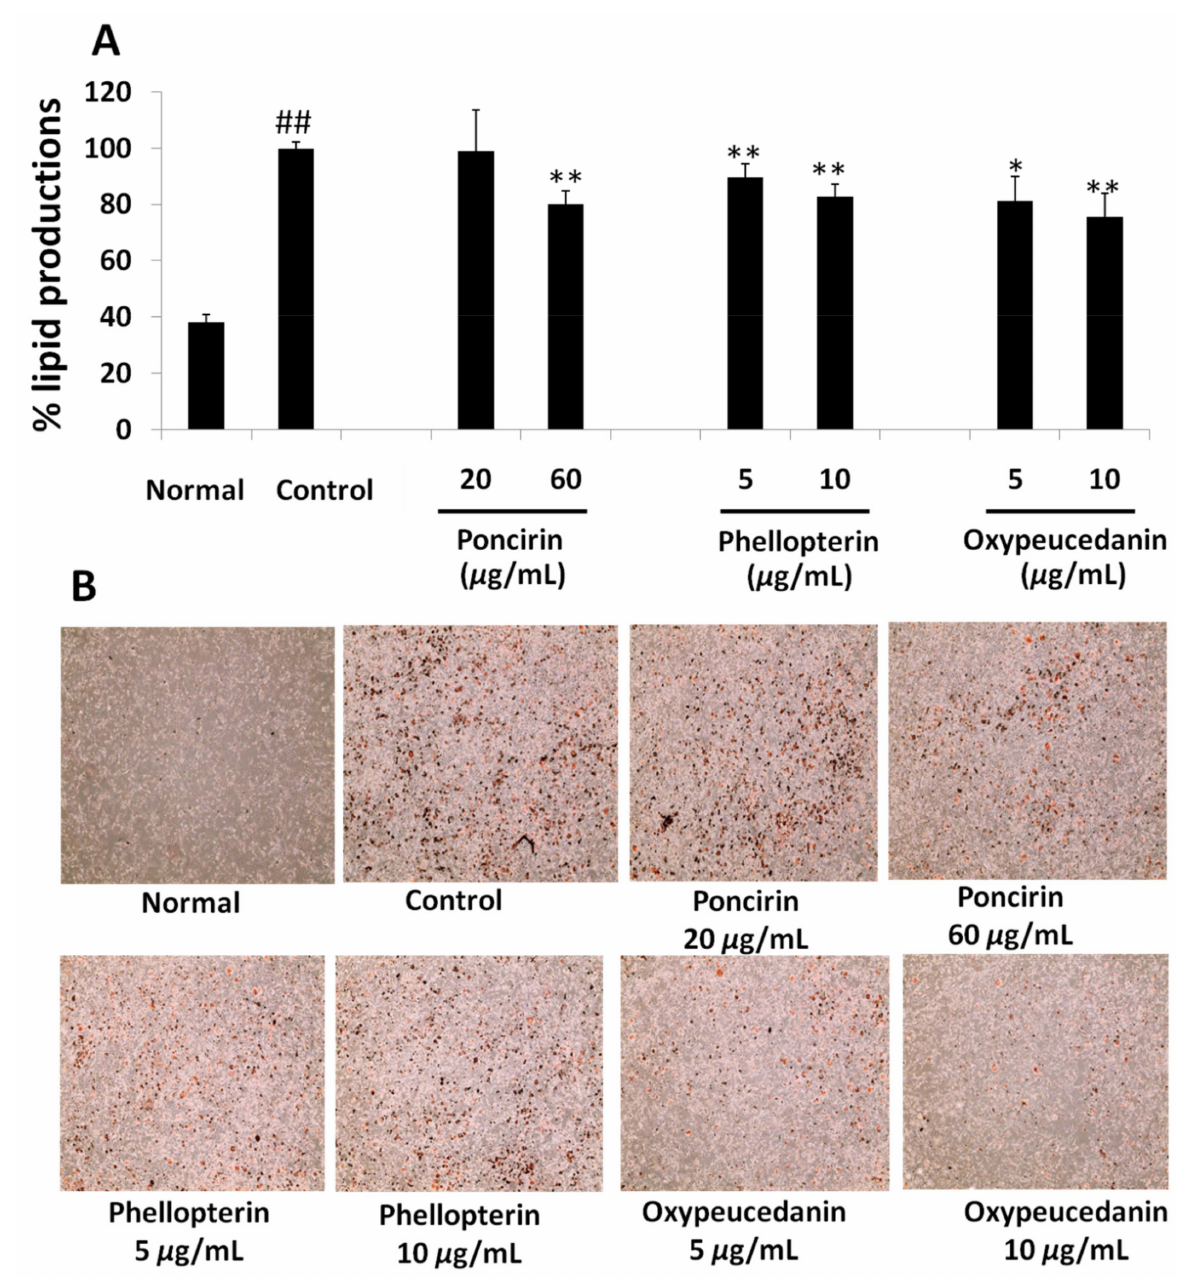
Figure 6. ( A )Effect of poncirin, phellopterin and oxypeucedanin treatment on percentage lipid deposition by 3T3-L1 cells using ORO assay. ( B ) Lipid accumulation in 3T3-L1 cell observed by EVOS XL microscope at 10 × magnification after ORO staining. Each set of data represents mean of triplicate experiments ± standard deviation. Significant difference between the groups was calculated using two-tailed Student’s t -test.* p < 0.05 vs. control, ** p < 0.01 vs. control, ## p < 0.01 vs. normal are used to represent significant difference in lipid production of the sample compared to non-treated control